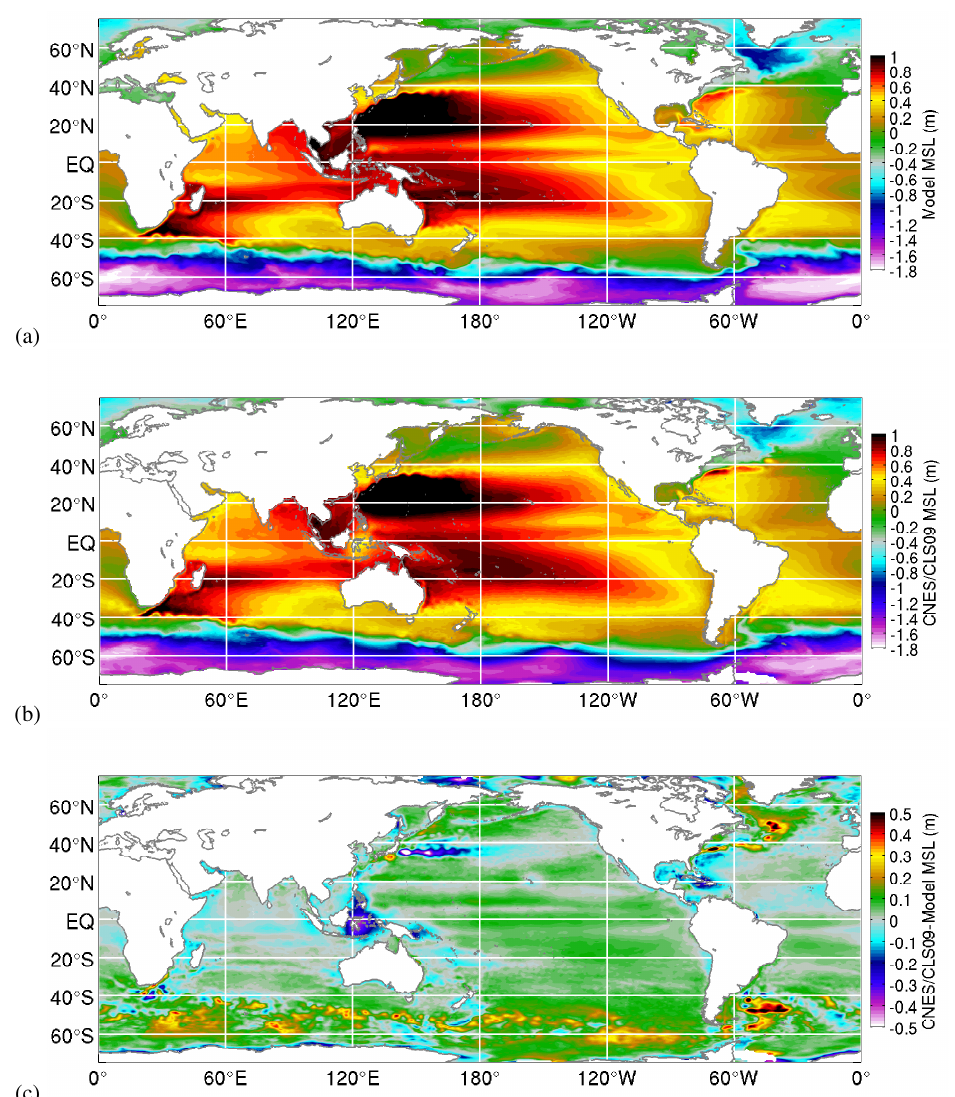
Fig. 1. Comparison of the (a) mean sea level from the model, (b) the mean dynamic topography from CNES-CLS09 V1.1, and (c) the difference between the CNES-CLS09 and the model MSL field.